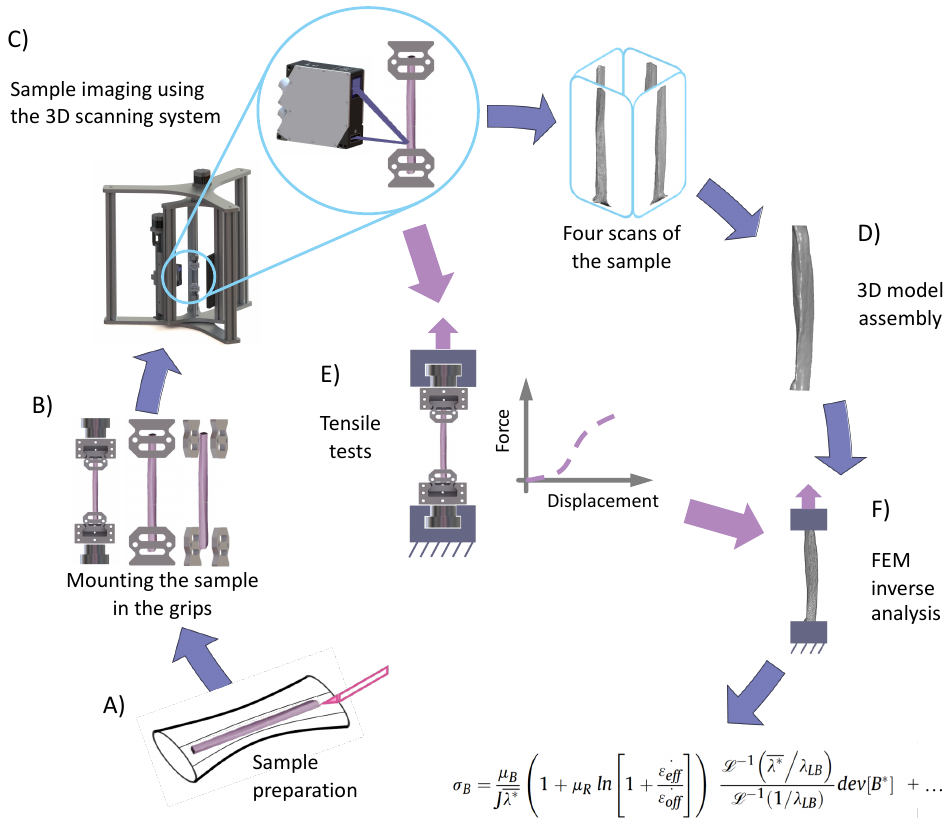
Figure 2. Flow diagram depicting the experimental process starting from the preparation of the samples ( A ), through mounting of the sample in replaceable inserts ( B ), scanning of the sample using the 3D scanning system ( C ), development of the 3D CAD model ( D ), up to the estimation of material model parameters using finite element method inverse analysis ( F ) based on force-displacement curves from tensile tests ( E ). Tensile tests were performed using the same gripping inserts that were used during 3D scanning of the sample, without changing the boundary